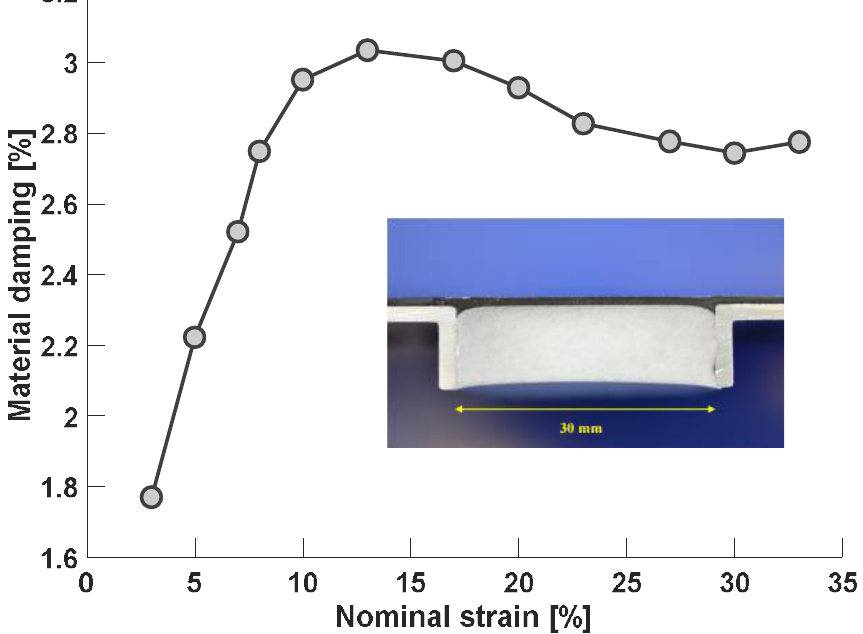
Figure 15. Damping factor, computed as the ratio between dissipated and elastic deformation energy, as function on the nominal strain.